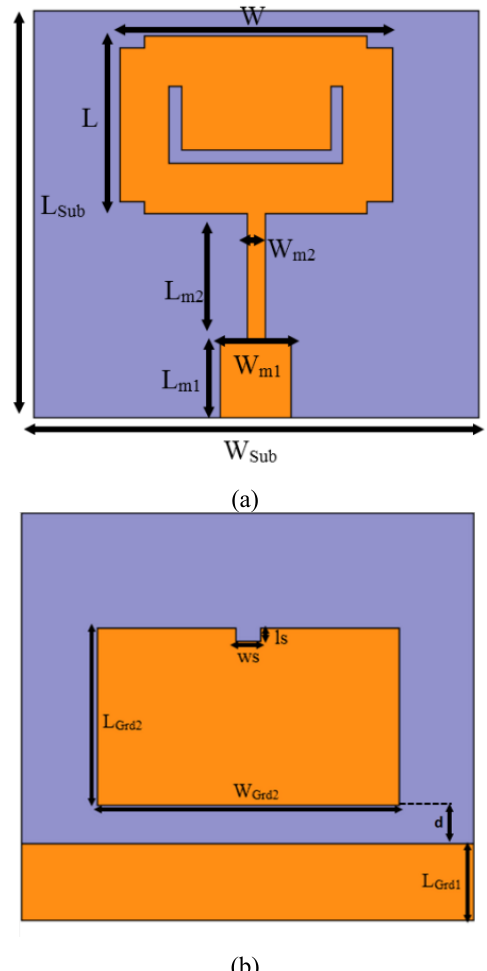
Fig. 2. The geometry of the proposed antenna, (a) Top view (b) Bottom